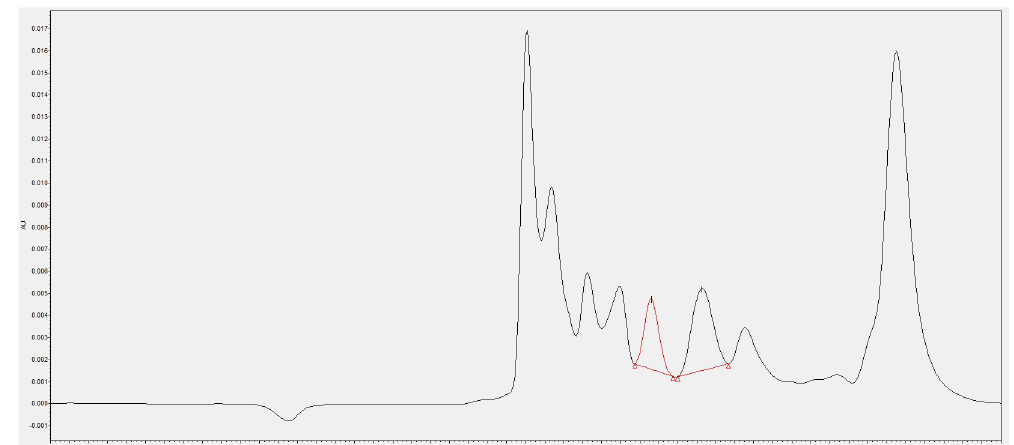
Fig 2. A chromatogram of cultured HeLa cells via using the optimised HPLC method. Absence of significant interference peaks at the retention times (6.344 minutes with a flow rate of 0.4 mL/min.) of Neu5Ac has been highlighted in red.